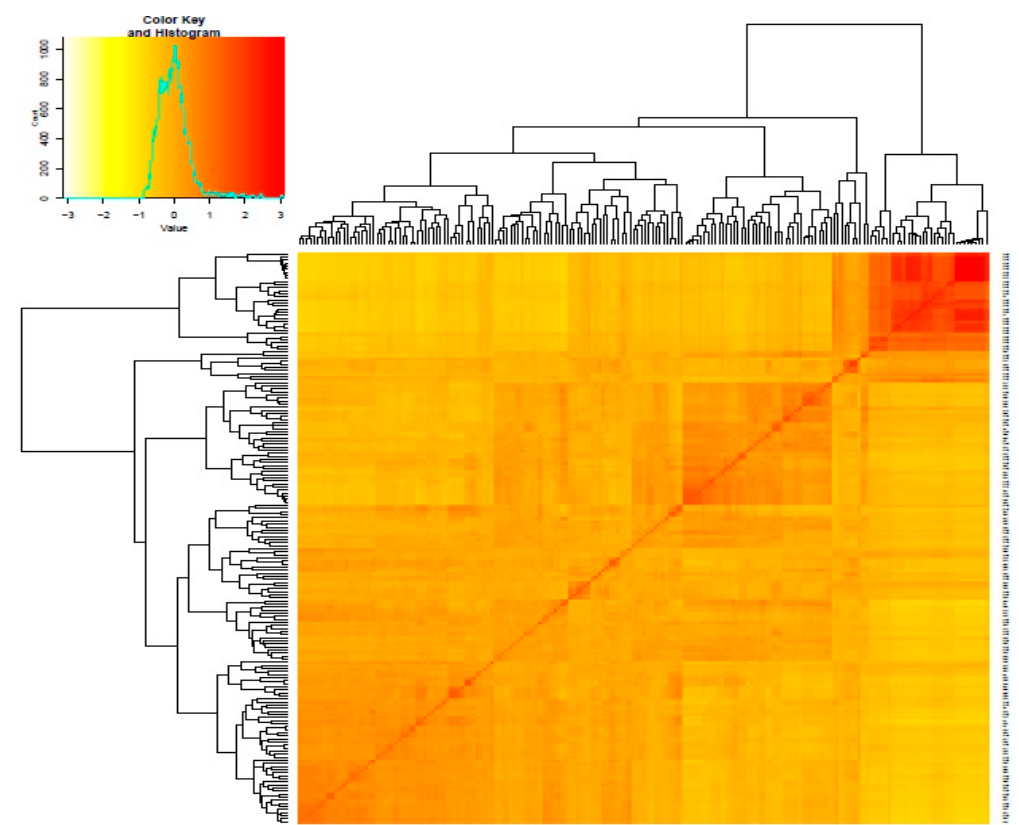
Figure 3. Heat map plot of kinship matrix using average linkage clustering based on SNP markers depicts the existence of four different groups among chickpea genotypes. The details of members of these groups are presented in Table S3.